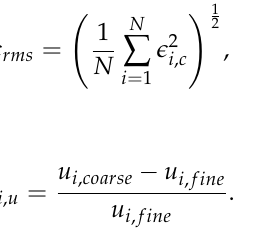
Table A5. Absolute and relative errors for the predicted profiles of Figure A3. ε a , ε r are averaged over the entire